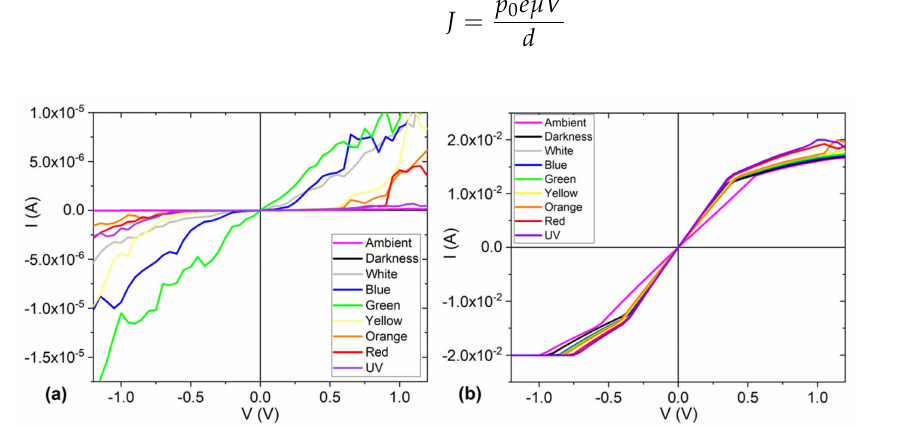
Figure 6. I-V characteristics of ( a ) ITO/FcPF 6 :DHAQ/nylon(ZnPc)/Ag and ( b ) ITO/FcPF 6 :DAAQ/ nylon(ZnPc)/Ag heterojunction devices at different illumination